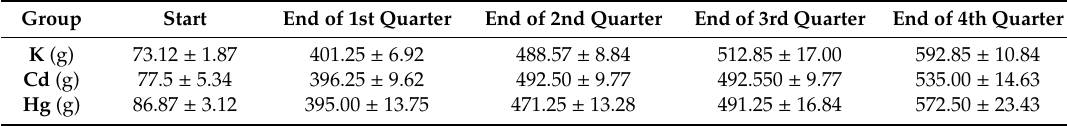
Table 2. Average weight of male rats ±